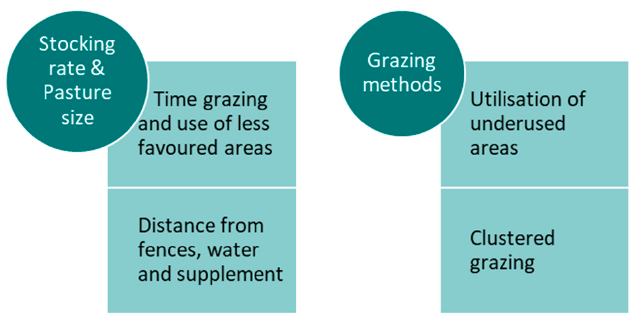
Figure 6. Summary diagram of the main variables of site use preference being affected by the management factor.